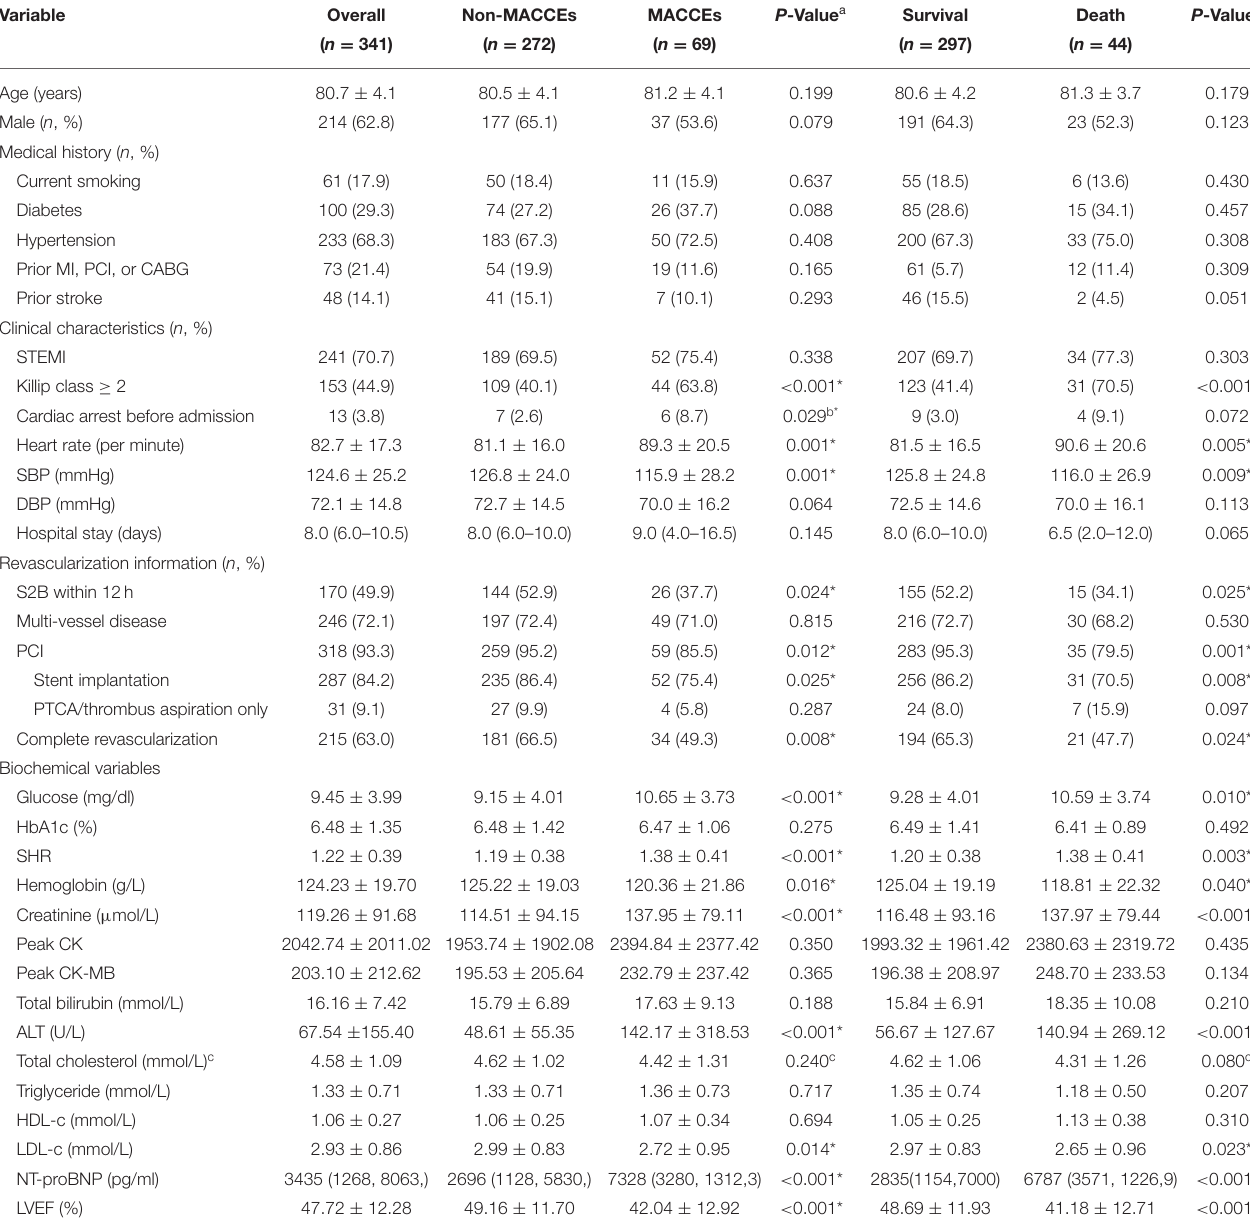
TABLE 1 | Baseline clinical characteristics of elderly patients with acute myocardial infarction.